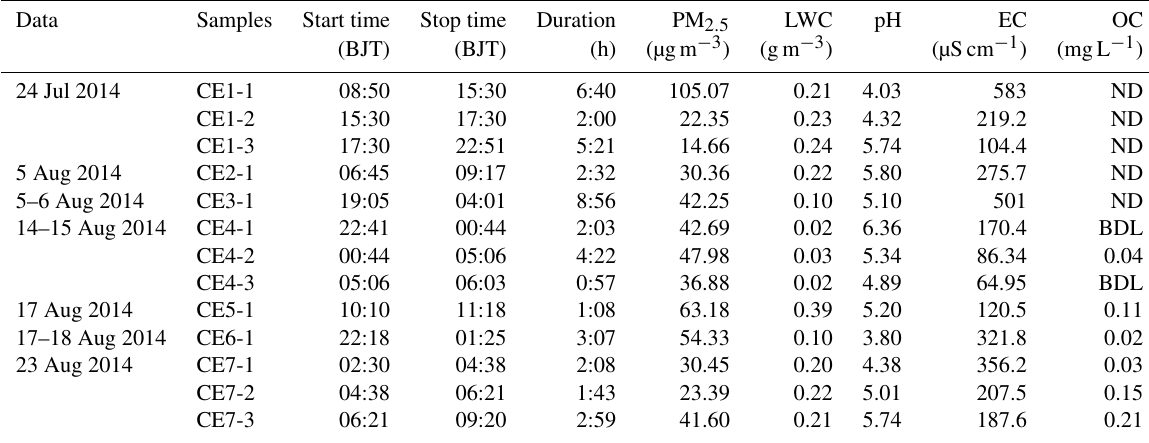
Table 1. Description cloud episodes at Mt Tai, China.